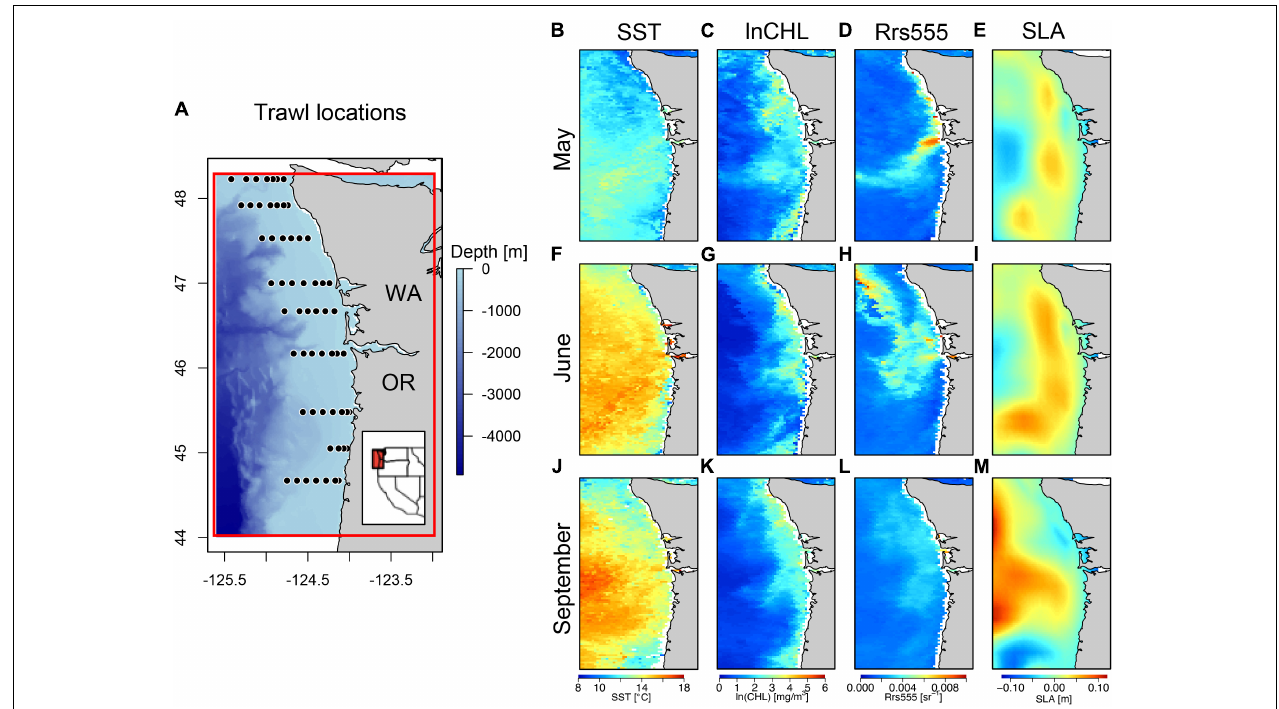
FIGURE 1 | Juvenile salmon and ocean ecosystem survey locations with remotely sensed oceanographic conditions. Locations where survey trawls were conducted off the coast of Oregon and Washington, United States and where in situ oceanographic conditions were measured (not in all years/months) along with images of (A) ETOPO bathymetry (m), (B) MODIS Sea Surface Temperature (SST [ ◦ C]), (C) MODIS Chlorophyll-a [mg/m 3 ], (D) MODIS remote sensing reflectance at 555 nm [sr - 1 ], (E) AVISO+TG Sea Level Anomaly [SLA (m)]. (B–E) Example monthly average composites of the remotely sensed data for month of May, (F–I) for June and (J–M) for September of 2006. Red box in inset extent map of the west coast of the United States corresponds to red box surrounding sampling extent in zoomed in bathymetric